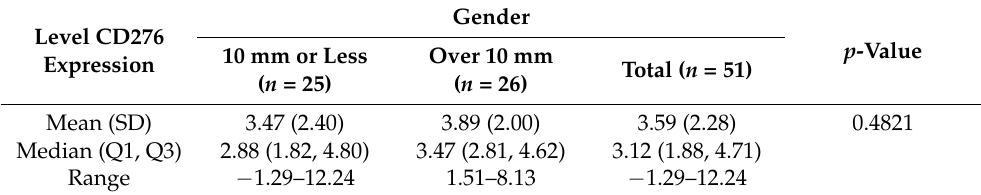
Table 5. Relationship between CD276 expression and gender.